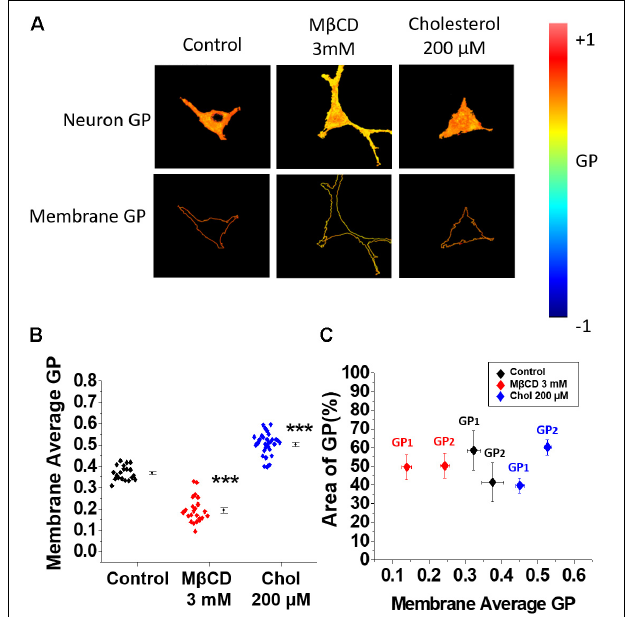
FIGURE 5 | Membrane fluidity changes after decreasing or increasing cholesterol levels. (A) Representative micrographs of hippocampal neurons showing the distribution of scaled GP values in the entire cell and in the membrane area under the experimental conditions previously described. (B) Average GP values showing a decrease in GP in membranes when neurons were treated with M β CD 3 mM. The opposite effect was found when the cells were incubated with 200 µ M of soluble cholesterol for 20 min. (C) Coverage analysis showing GP changes in two populations of the membrane domains (GP1 and GP2) for each of the conditions described in (B) In the presence of 3 mM M β CD both domains exhibit lower GP values (more fluid) compared to control conditions, while the addition of cholesterol produce dehydration of both lipid domain populations, becoming more rigid and exhibiting higher GP values. The graphs represent the mean ± SEM. Asterisks denote: ∗∗∗ p <